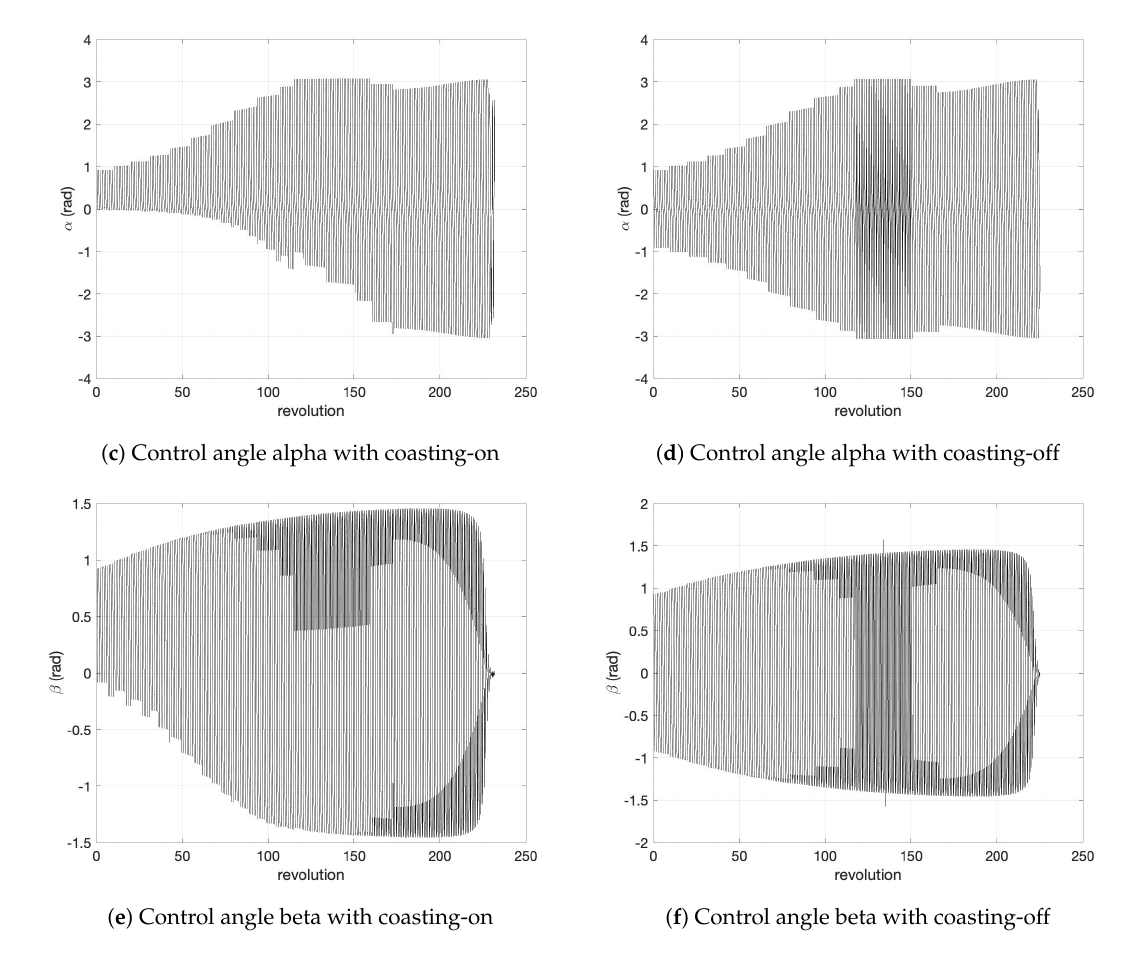
Figure 7. Trajectory and control angles of GTO-GEO.